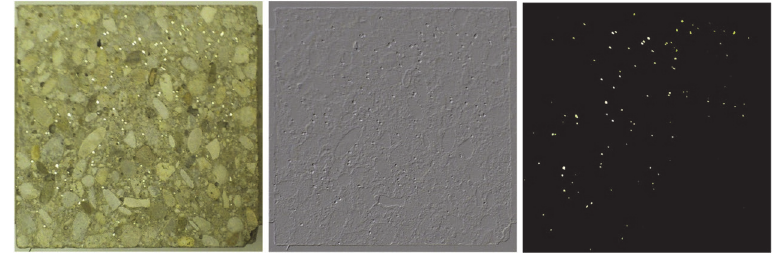
Figure 8. Image processing procedures